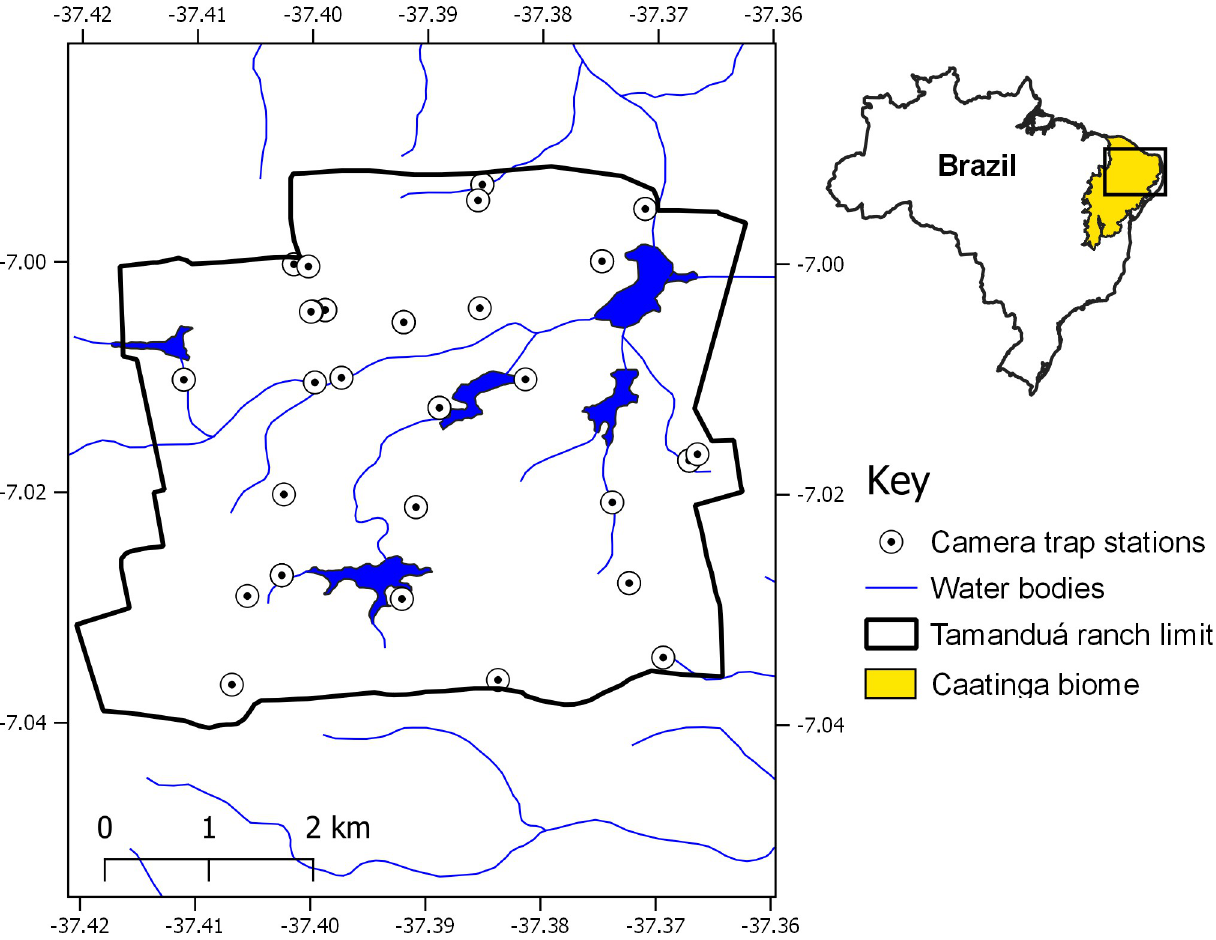
Fig 1. Study area and camera trap stations at the Tamandua´ Ranch in the Brazilian Caatinga.